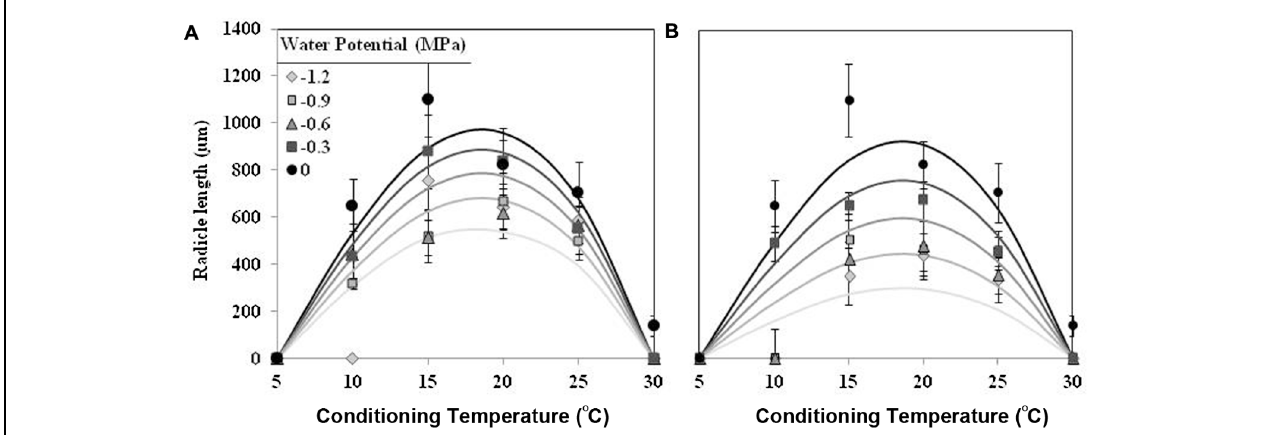
FIGURE 2 | Effects of temperature ( ◦ C) and matric (A) or osmotic (B) potentials (MPa) on radicle length of O. crenata seeds during conditioning period. The lines were fitted according to Analysis β equation (Hau and Kranz, 1990; Table 1 ). Points represent the average of six repetitions. Bars represent the SD of the